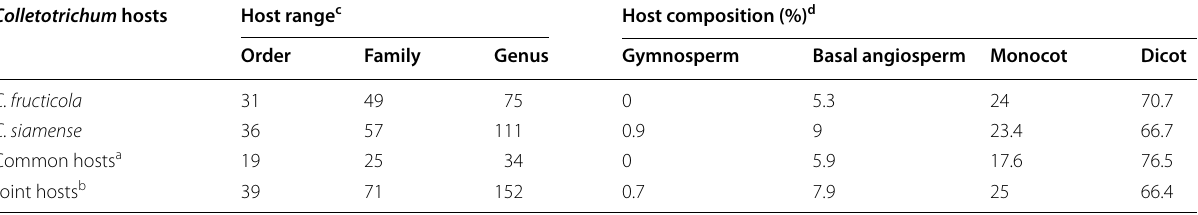
a Genera of plants commonly hosting both C. fructicola and C. siamense b Genera of plants hosting C. fructicola and/or those hosting C. siamense were combined c Host range was retrieved on July 8, 2022 at https:// nt. ars- grin. gov/ funga ldata bases/ (Far and Rossman 2022). The taxonomy of each host was determined at https:// www. iplant. cn/ d Host composition is expressed as the percentage (%) of hosts belonging to distinct phylogenetic clades at genus level